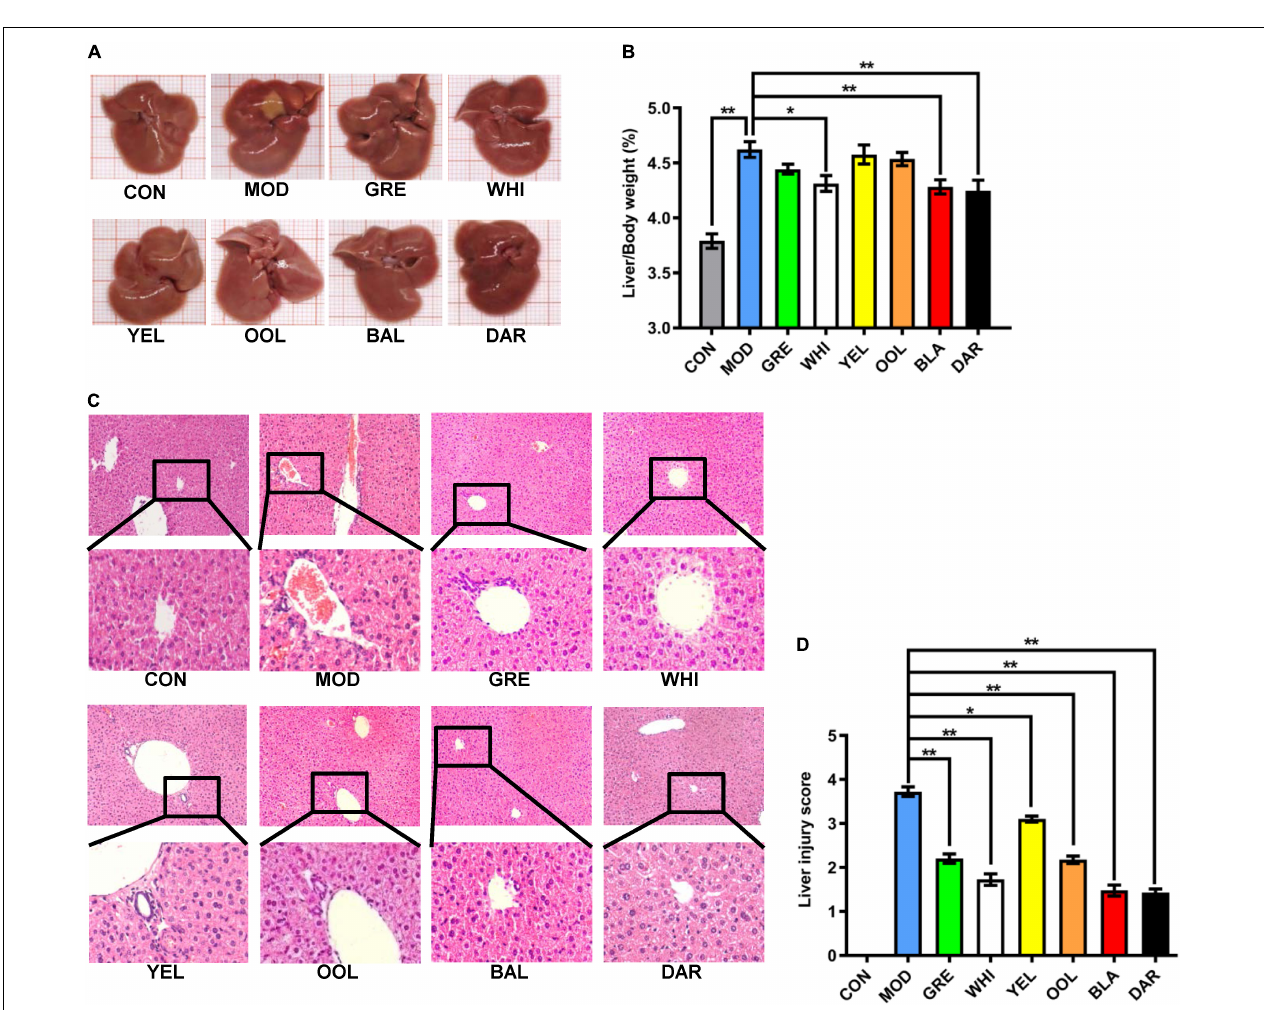
FIGURE 3 | Effect of WEATs treatment on liver morphology (A) , liver/body index (B) , HE staining (C) , liver injury score (D) . Each value represents the mean ± SEM ( n = 10). * p < 0.05 vs. MOD; ** p < 0.01 vs. MOD.